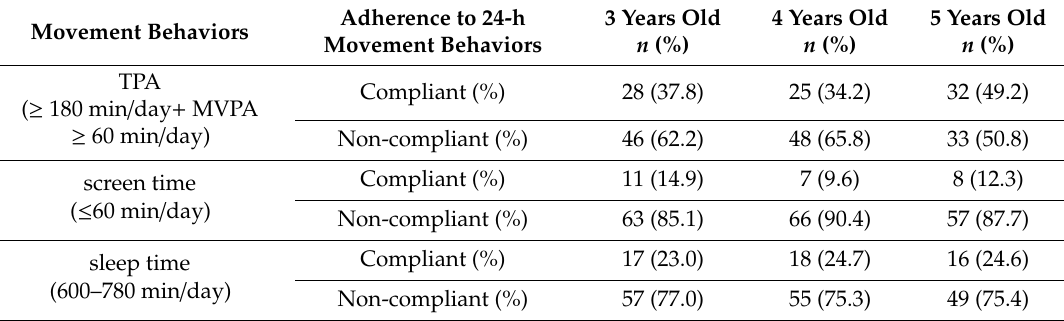
Table 2. Percentage of guideline compliance among preschoolers by age.